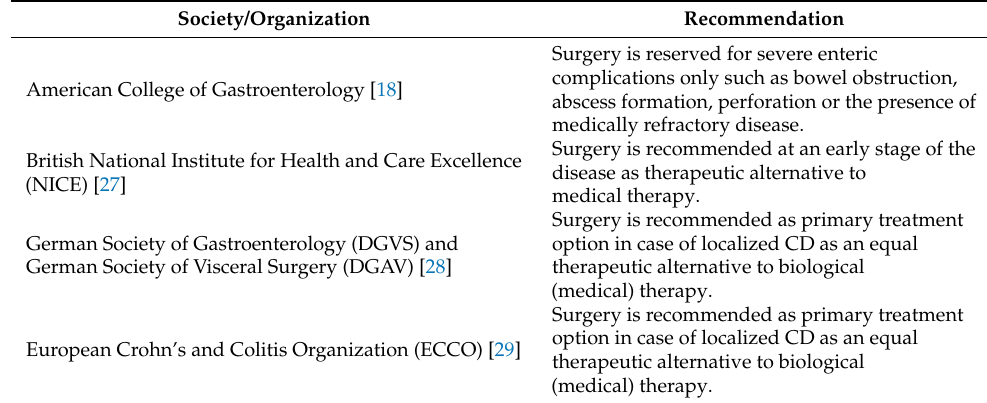
Table 1. Recommendation of international guidelines regarding isolated ileocolonic Crohn’s disease.